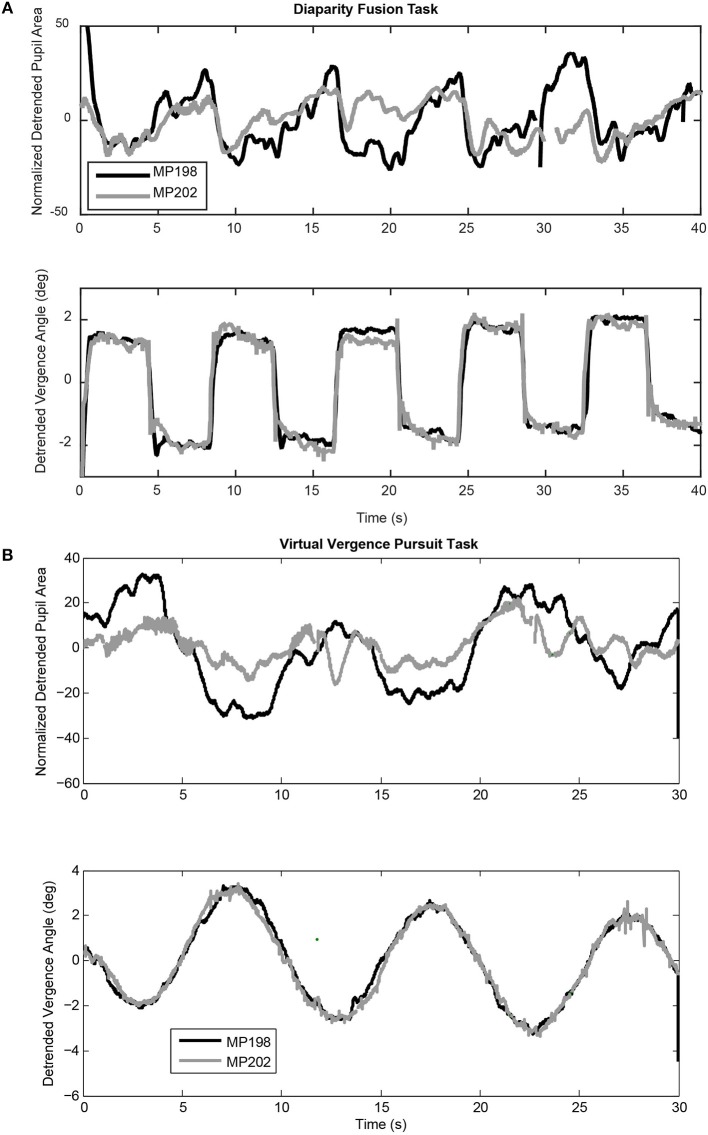
Examples of coordinated pupil and eye movements during the virtual binocular disparity vergence task. (A) Detrended data from two subjects (MP198 and MP202) during a step binocular disparity fusion task. The upper panel shows the normalized pupil area traces and the lower panel shows the ocular vergence angle relative to the tropia at calibration. (B) Detrended data from the same subjects for a binocular disparity tracking task at 0.1 Hz. Note the highly consistent vergence eye movements for both the binocular disparity step tasks and the disparity tracking tasks of both subjects. Data from MP198 before detrending are shown in the supplemental data section (Figure S1).